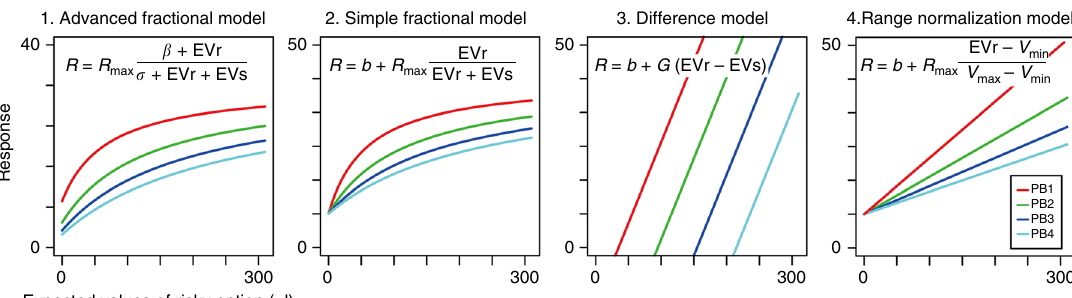
Fig. 3 Potential normalized value coding models. Schematic depiction of predicted neuronal responses in the four alternative normalized value coding models. In each panel, four colored lines indicated the model output ( y- axis) in each of payoff block (PB1 – 4) plotted against the expected values of risky option ( x -axis). Expected values of safe option were 60, 120, 180 and 240 μ l in PB1 to 4, respectively. Model equations are shown in each plot. R max , β , σ , b and G were free parameters. For this schematic drawing, the following values for free parameters were used; 1. Advanced fractional model, R max , β and σ were 40 spk s − 1 , 20 and 10 μ l, respectively; 2. Simple fractional model, R max and b were 40 and 10 spk s − 1 , respectively; 3. Difference model, G and b were 0.4 (a.u.) and 10 spk s − 1 , respectively; 4. Range normalization model, R max and b were 40 and 10 spk s − 1 , respectively. See Methods for more